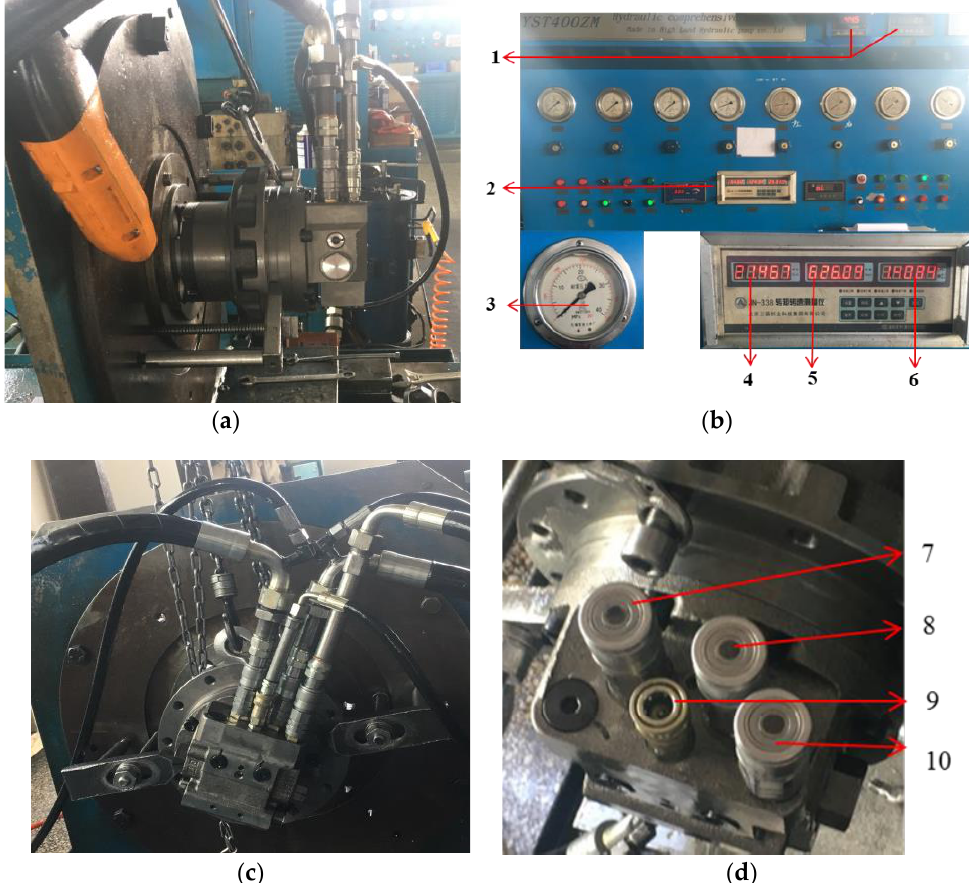
Figure 27. Leakage and torque experimental device. ( a ) is the side view of the experimental device; ( b ) is an instrument display device; ( c ) is the experimental installation diagram of the port plate pair; ( d ) is the oil mouth device. (1) Inlet and outlet flow and return oil, (2) JN338M-A torque speed measuring instrument, (3) vibration-proof pressure gauge, (4) torque, (5) velocity, (6) output power, (7) oil inlet port, (8) oil out port, (9) variable port, (10) oil returning port.